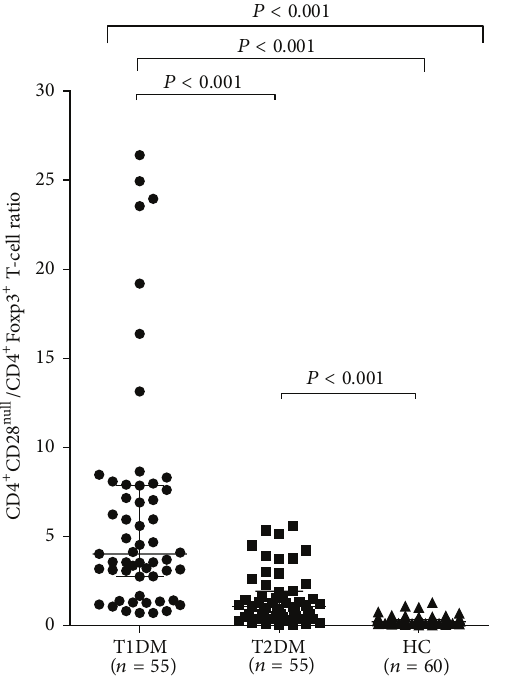
Figure 3: CD4 + CD28 null /CD4 + FoxP3 + percentage ratio in different groups. T1DM, T2DM, and control groups were defined as in Fig- ure 1. Data are presented as single data points. A significantly higher CD4 + CD28 null /CD4 + FoxP3 + ratio was detected in T1DM patients than in T2DM and in controls. CD4 + CD28 null /CD4 + FoxP3 + ratio was also higher in T2DM patients than in controls.